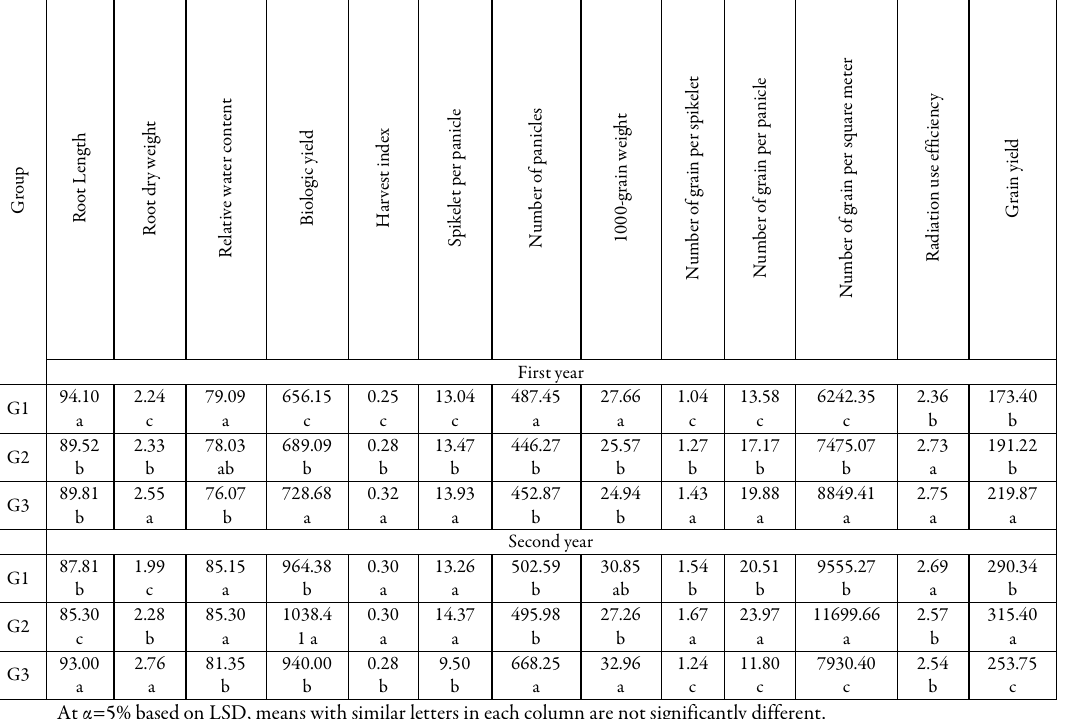
Table 5. Mean comparison between different groups of cluster analysis based on different studied traits at two crop